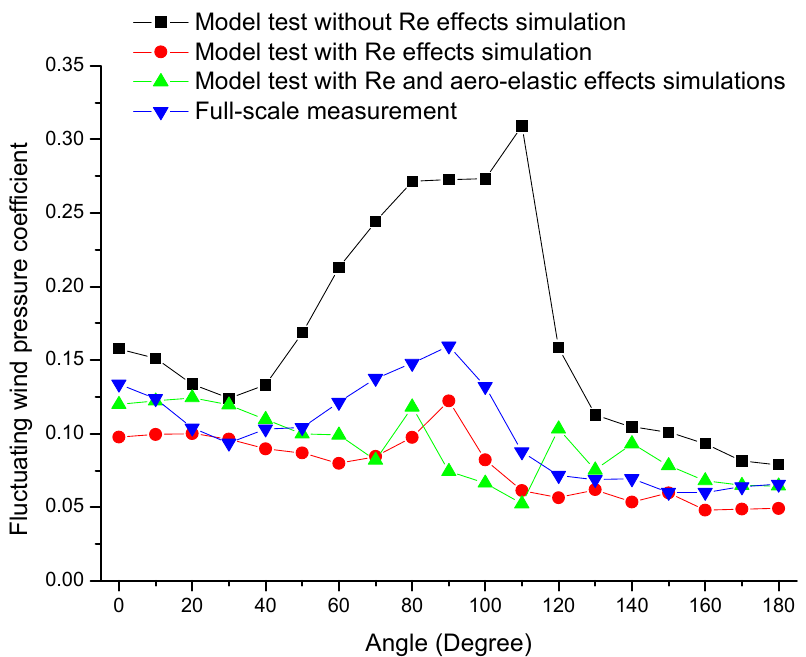
Figure 12. Fluctuating wind pressure distributions from full-scale measurement and model tests.